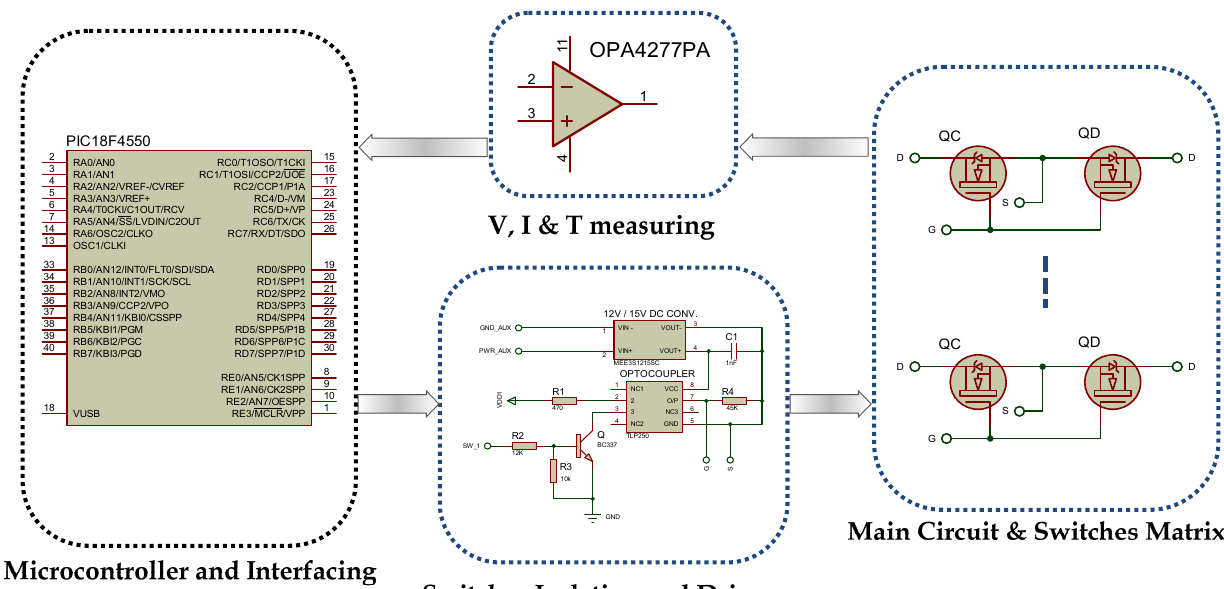
Figure 15. SSC slave control circuit global view [39]. Reprinted/Reproduced with permission from 2013 [39].